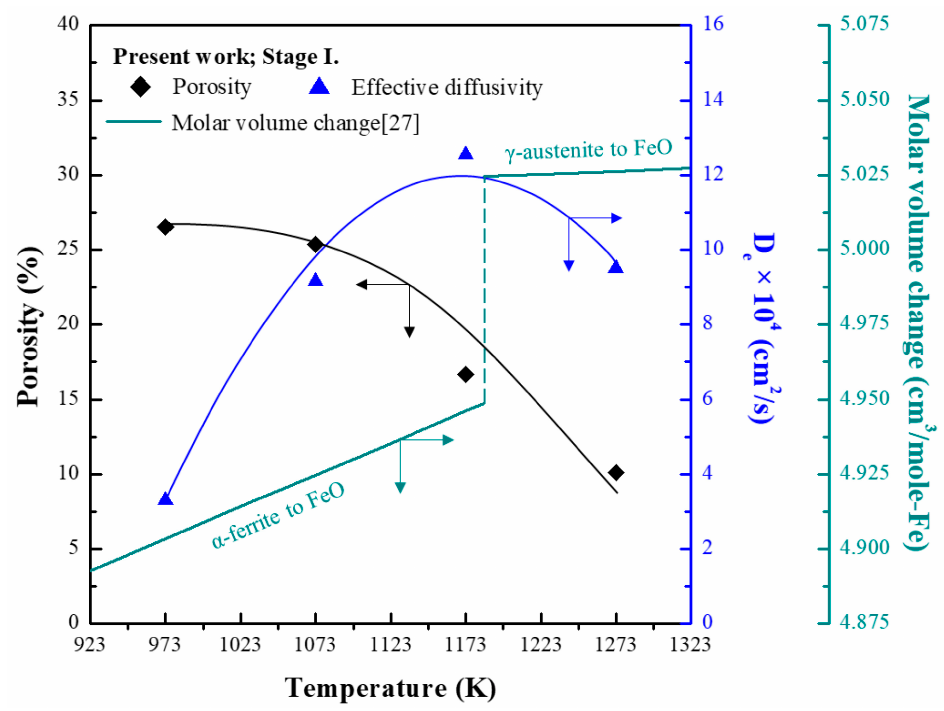
Figure 8. Porosity, effective diffusivity, and molar volume change during oxidation of PRI after the reaction under the experimental conditions of Stage I.